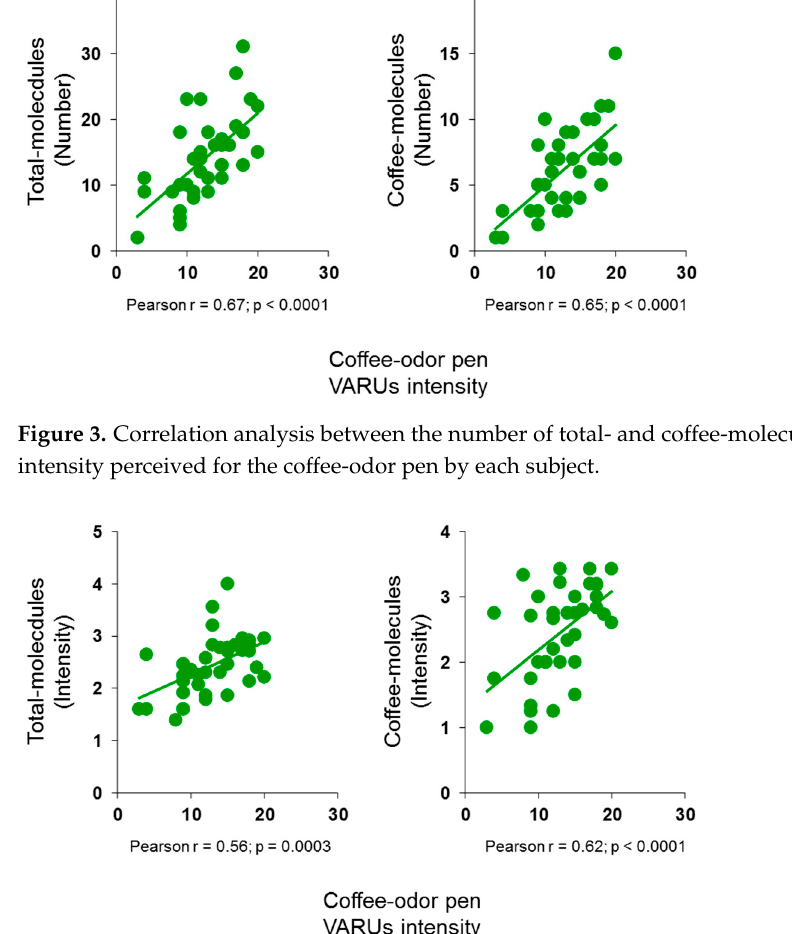
Figure 4. Correlation analysis between the average intensity referred for total- and coffee-molecules and the intensity perceived for the coffee-odor pen by each subject.